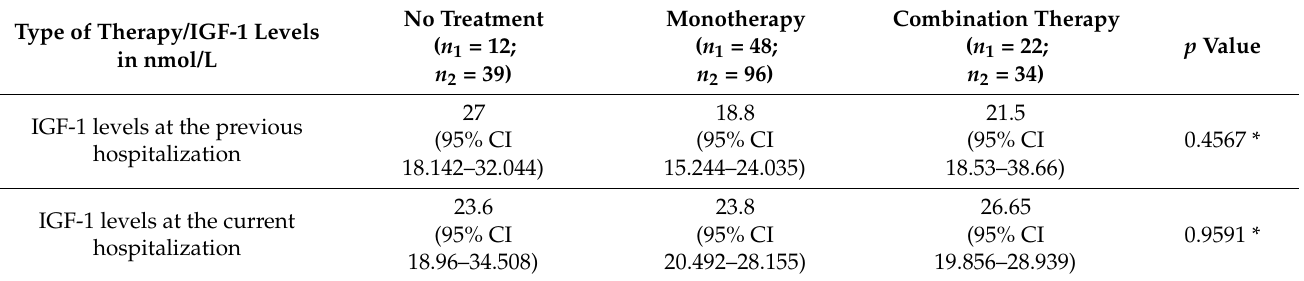
Table 2. IGF-1 levels and type of therapy by number of included medicines in the therapeutic scheme.